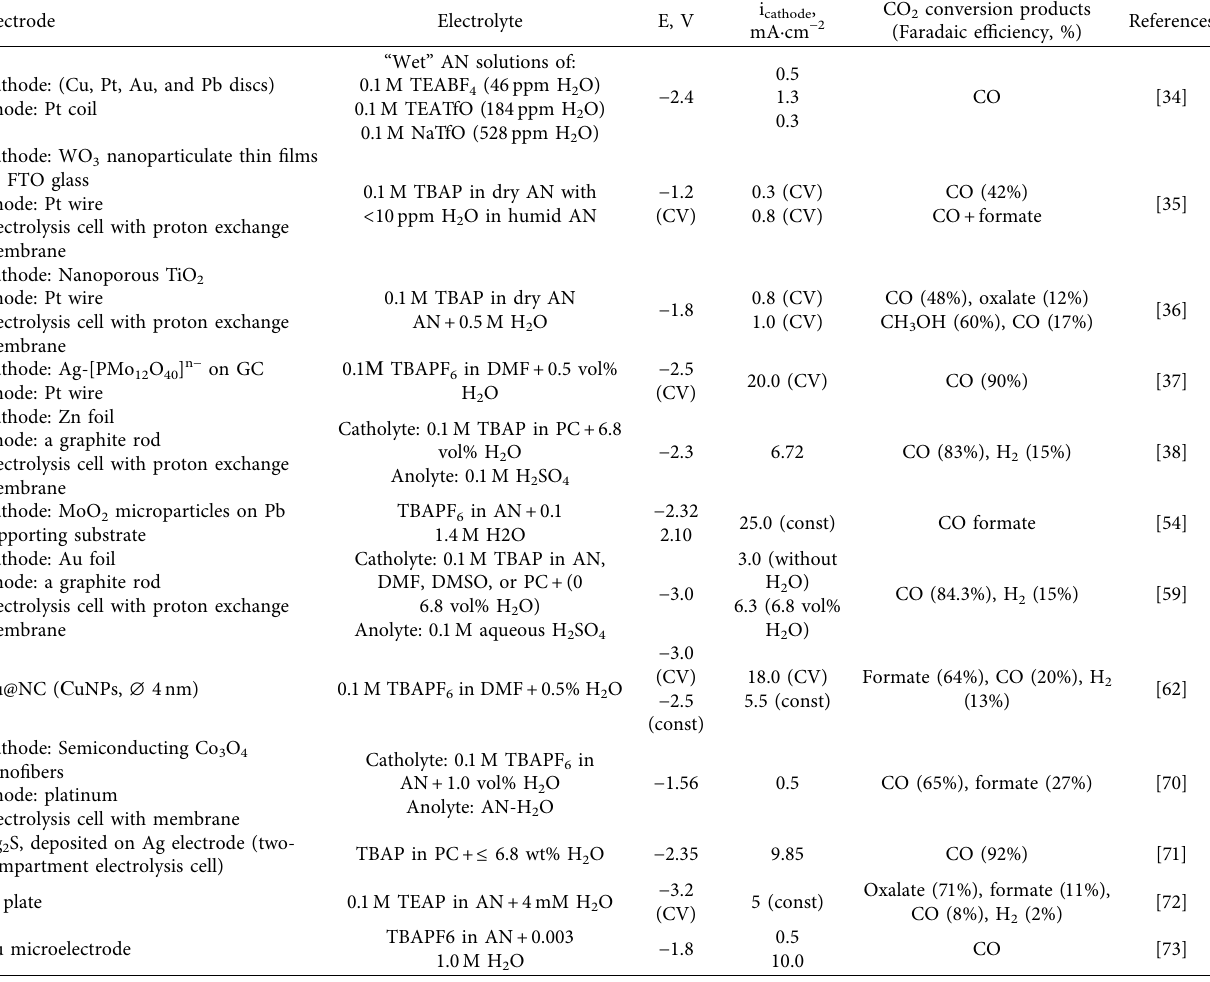
Table 2: Examples of CO 2 electrochemical reduction by catalytic active cathodes in aprotic solvents with the addition of water. Electrode Electrolyte